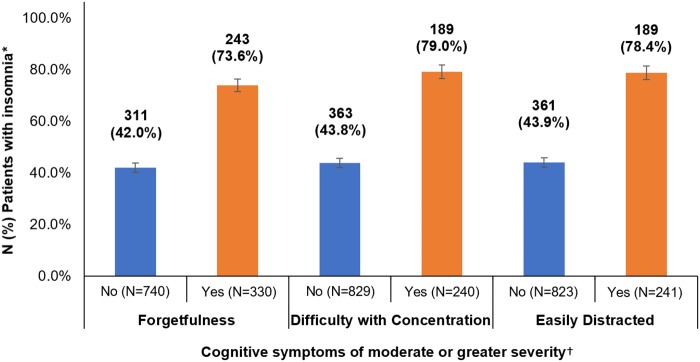
Prevalence of insomnia among breast cancer survivors with moderate or greater perceived cognitive impairment.*Insomnia is defined as score ≥8 on the Insomnia Severity Index.†Score ≥2 on a Breast Cancer Prevention Trial cognitive item (ie, forgetfulness, concentration, distractibility) indicates moderate or greater severity of the cognitive symptom. Because of missing data, some variables do not add up to 1072.